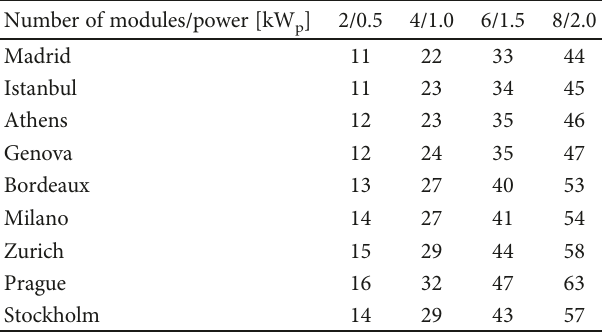
Table 3: Optimum load resistance for di ff erent sizes of PV array in di ff erent climates.